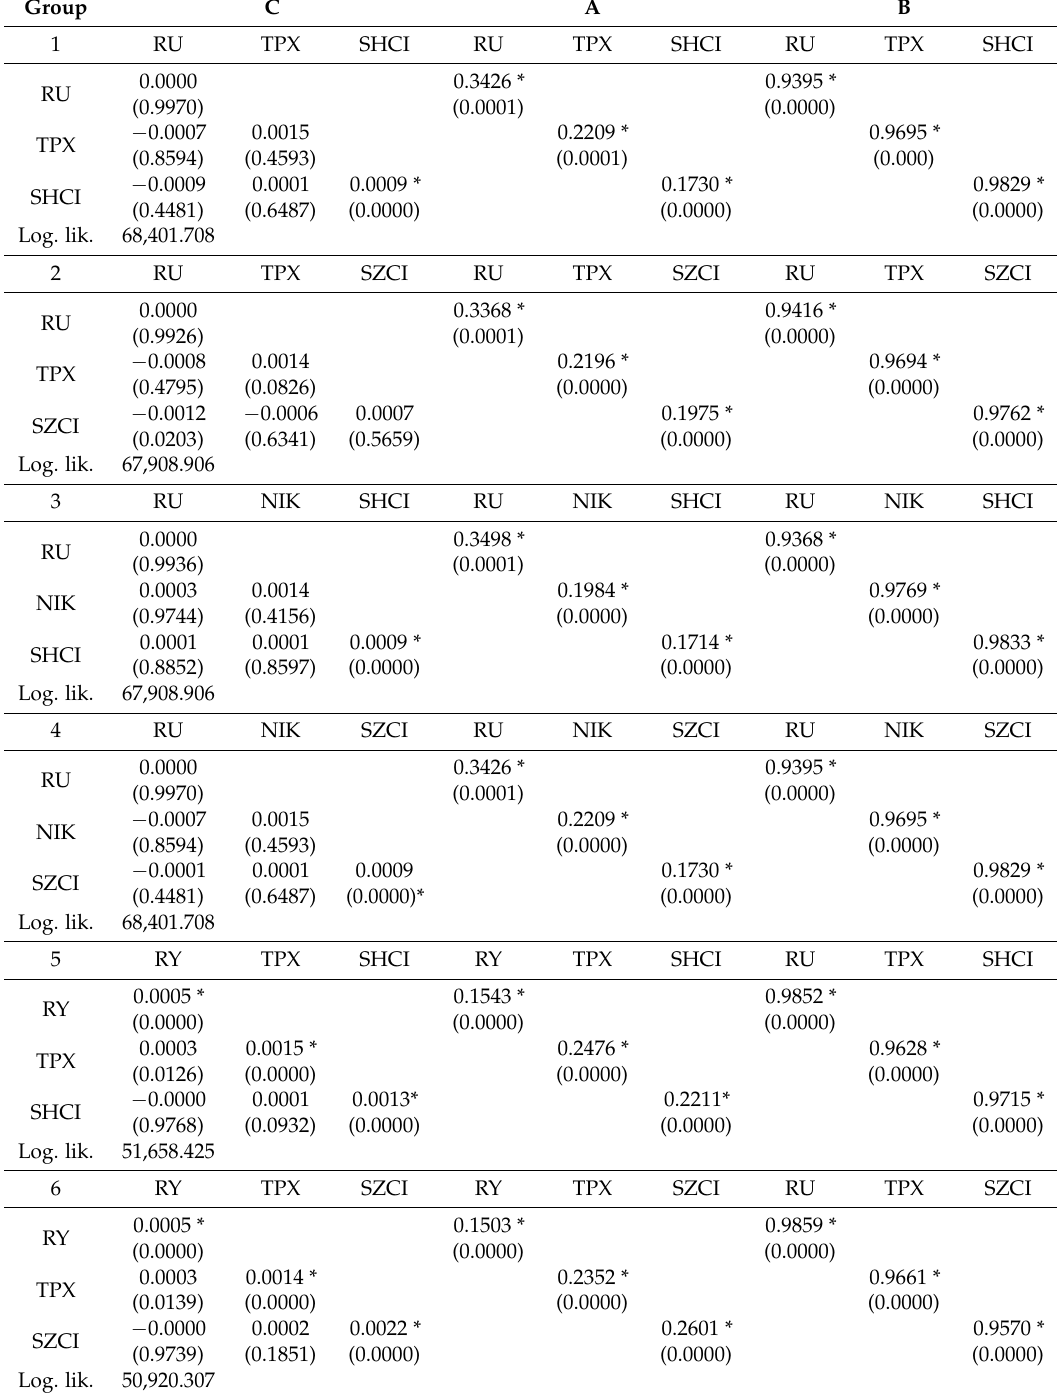
Table 5. Estimation Results of the Variance Equations in the Diagonal BEKK GARCH-M